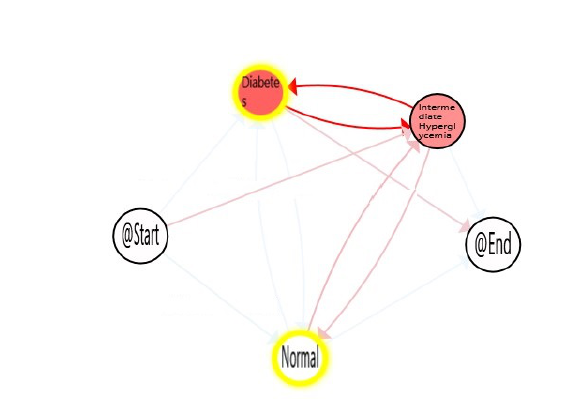
Figure 13. Differences between Adult-Elderly cohorts.